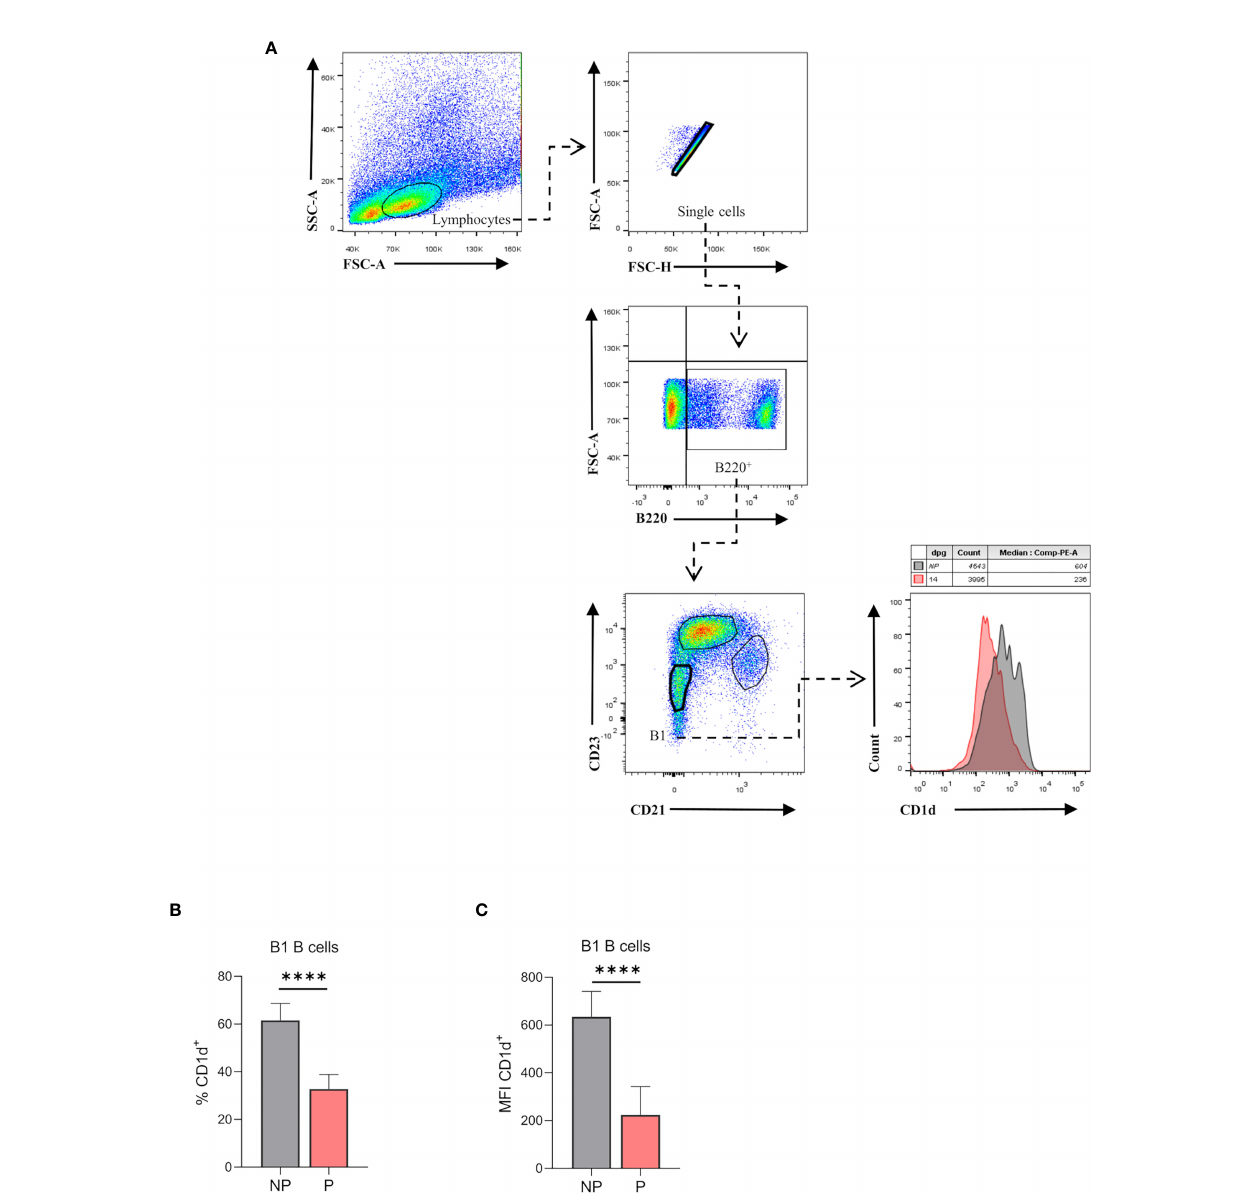
FIGURE 6 | (A) . Percentages of CD1d expressing-B1 B cells in pregnant and non-pregnant mice. Representative pseudocolor plots showing gating strategy used to quantify CD1d expression on B1 B cells from the spleen of pregnant (P) and non-pregnant mice (NP). Lymphocytes were gated by FSC vs. SCC, and dead cells and doublets were eliminated. Then B220 CD23, and CD21 markers were used to de fi ne the B1 B cell subset (B220 low CD23 - CD21 - ). Auto- fl uorescence of each biological replicate was used as a negative control for B220, CD23, and CD21. Additionally, CD1d expression was assessed in this population, using FMO as control. (B) . Percentages of B1-CD1d B cells in pregnant and non-pregnant mice. Percentages of B1-CD1d B cells were signi fi cantly diminished in pregnant (P) (37.8 ± 2.4; n=5) as compared to non-pregnant (NP) (61.6 ±3.1; n=5) mice. (C) . Mean fl uorescence intensity (MFI) of CD1d on B1 B cells in pregnant and non-pregnant mice. MFI of CD1d on B1 B cells (B220 low CD23 - CD21 - ) was signi fi cantly diminished in P (224±42; n=5) as compared to NP (634.4±47.7; n=5) mice. Unpaired Student ’ s t-test ( a =0.05), (****)